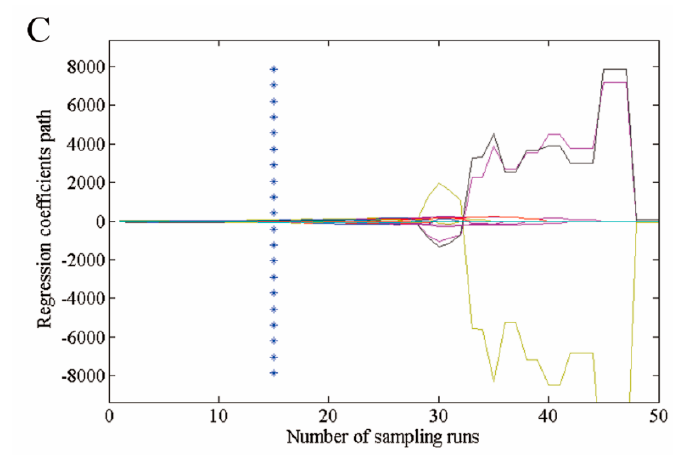
Figure 6. Selected optimal wavelengths by competitive adaptive reweighted sampling (CARS). ( A ) The number of variables as the function of iterations; ( B ) ten-fold root mean squared errors (RMSECV) values; and ( C ) regression coefficients of each variable with the number of sampling runs. Each line denotes the path of a variable.